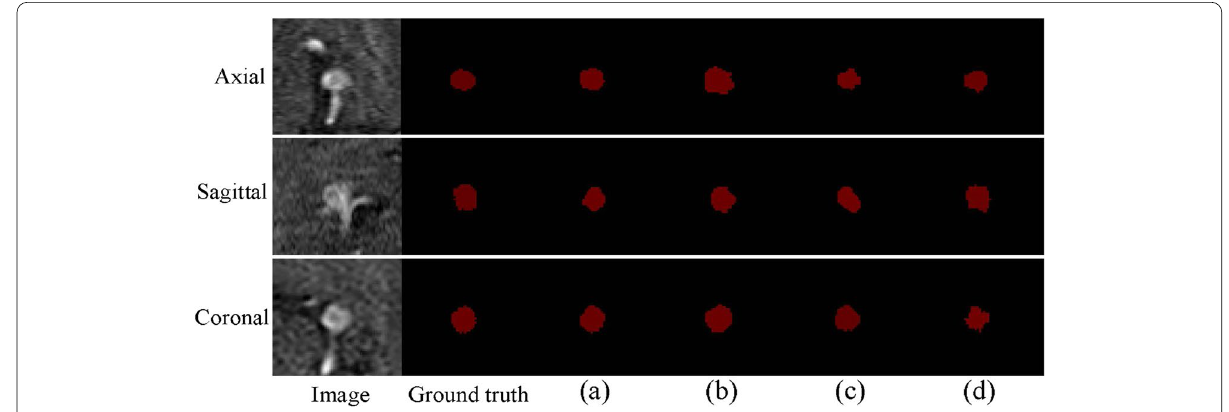
Fig. 7 Prediction maps of different attention modules, on the ADAM test set. a The proposed model; b SENet; c SKNet; d